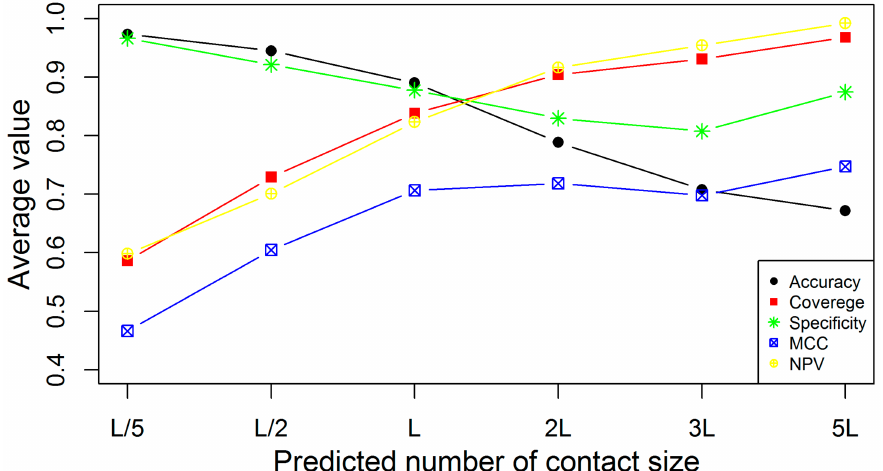
Figure 4. The average accuracy, coverage, specificity, NPV, and MCC of COMTOP in terms of the predicted contact size on the 239 non-redundant